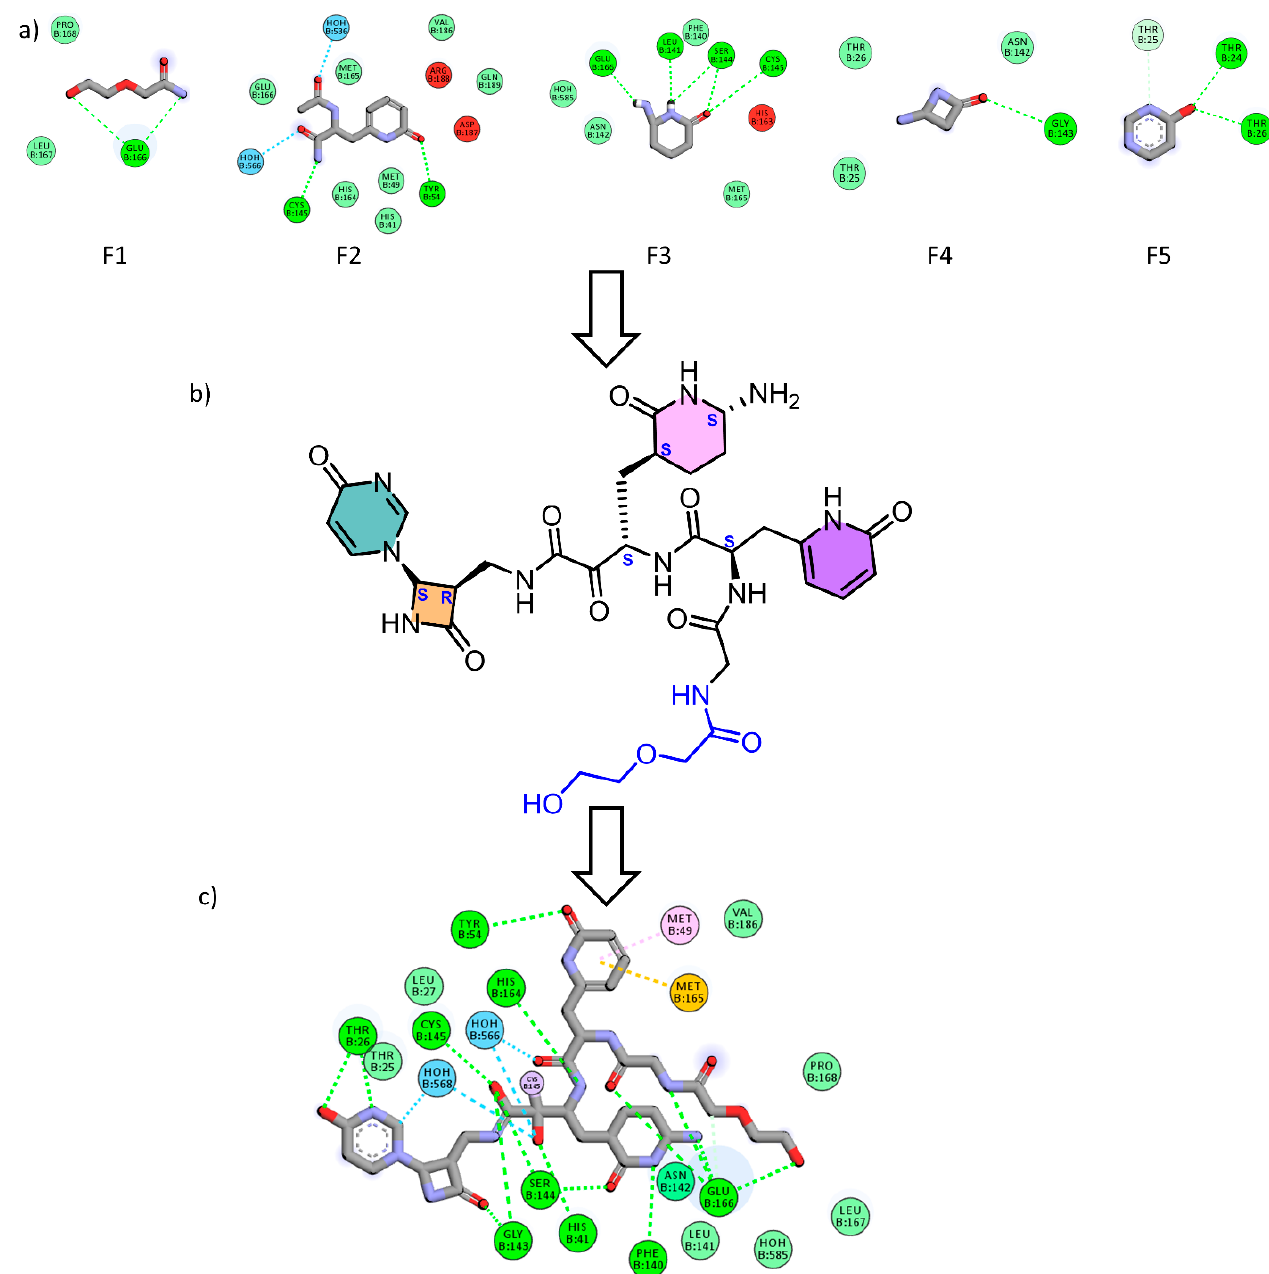
Figure 2. ( a ) The five generated fragments from FBDD, ( b ) the designed compound RMH148 after fragment linking, ( c ) the 2d binding diagram between RMH148 and Mpro.